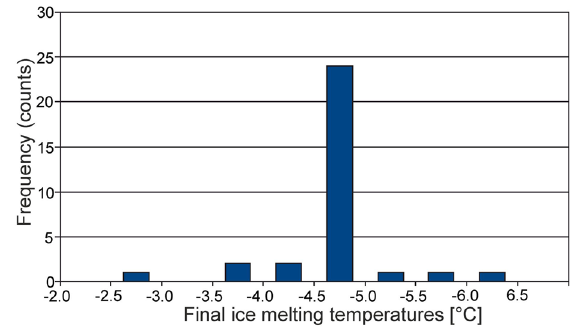
Figure 6. Histogram of the ice melting temperature in primary inclusions.